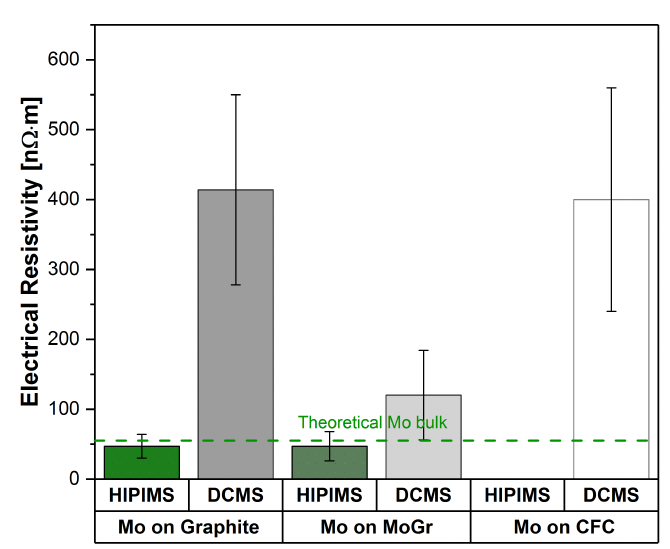
Figure 7. Comparison of measured resistivity of Mo coating layers produced with HIPMS and DCMS techniques on graphite, MoGr and CFC substrates.